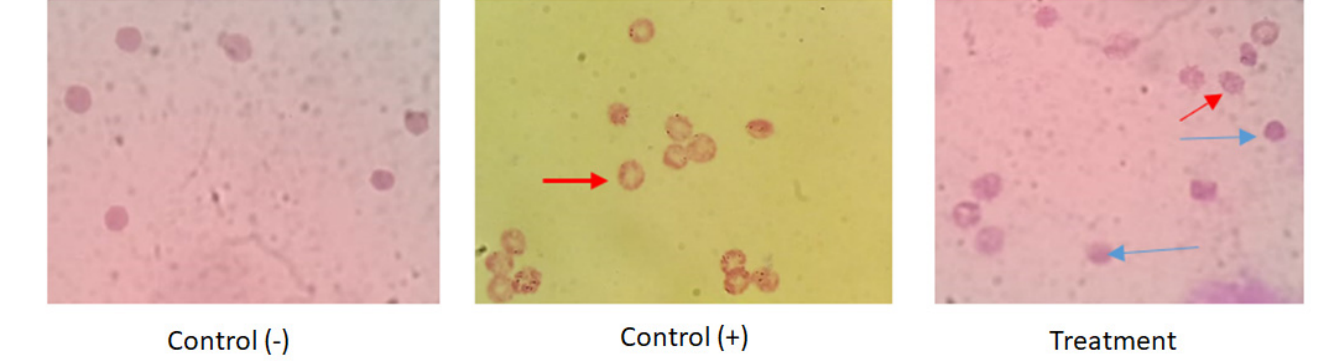
Figure 3. The impact of B. cernua extract addition to the malarial parasite-infected erythrocytes (Giemsa staining). Control ( − ): erythrocytes; control (+): erythrocytes + P. falciparum ; treatment: erythrocytes + P. falciparum + methanol extract at 5 ppm. Red arrow: infected erythrocytes at the ring formation stage; blue arrow: intact cells following extract treatment.